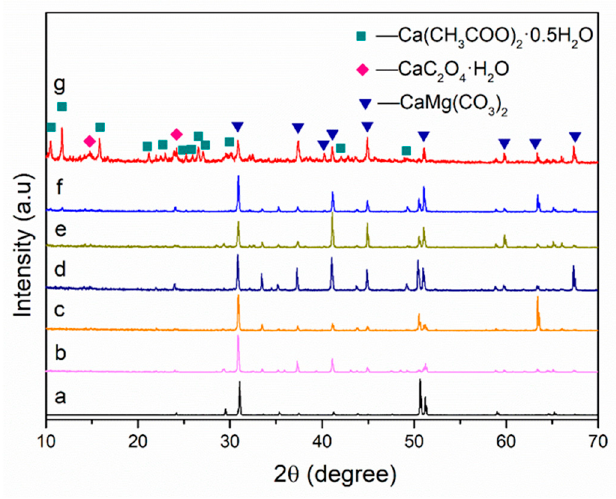
Figure 2. XRD patterns of treated and untreated samples: (a) UT, (b) AO, (c) 0.02 mol/L CA, (d) 0.04 mol/L CA, (e) 0.06 mol/L CA, (f) 0.08 mol/L CA, (g) 0.10 mol/L CA.